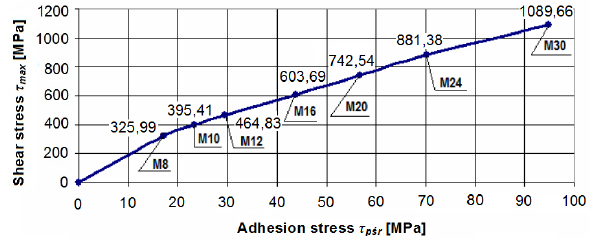
Figure 18: Dependency shear stress – adhesion stress for diagonal